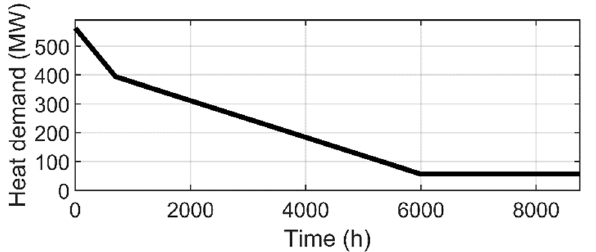
Figure 5. Duration curve of the district heat demand. Data simplified from [46].